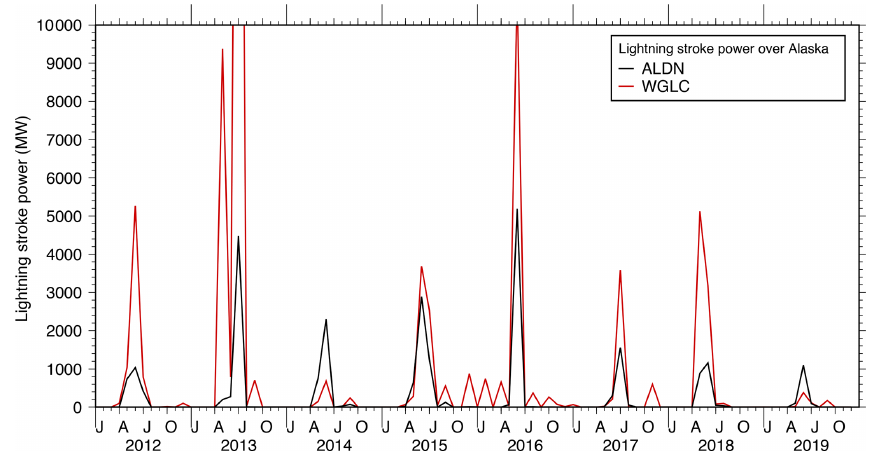
Figure 12. Time series of median power per stroke over Alaska.